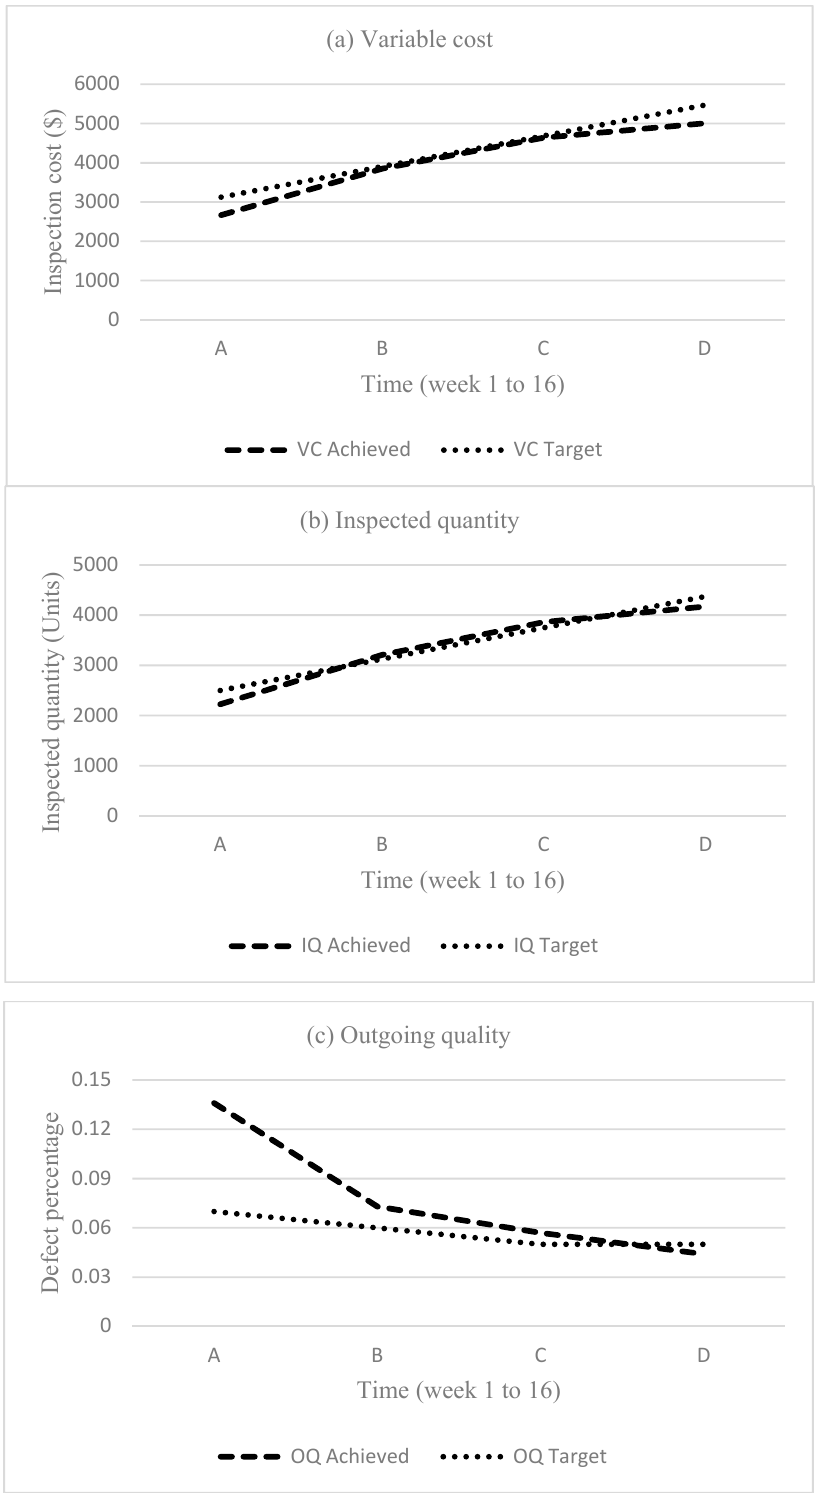
Figure 3. Evaluation of objective functions with the same combination of inspectors.